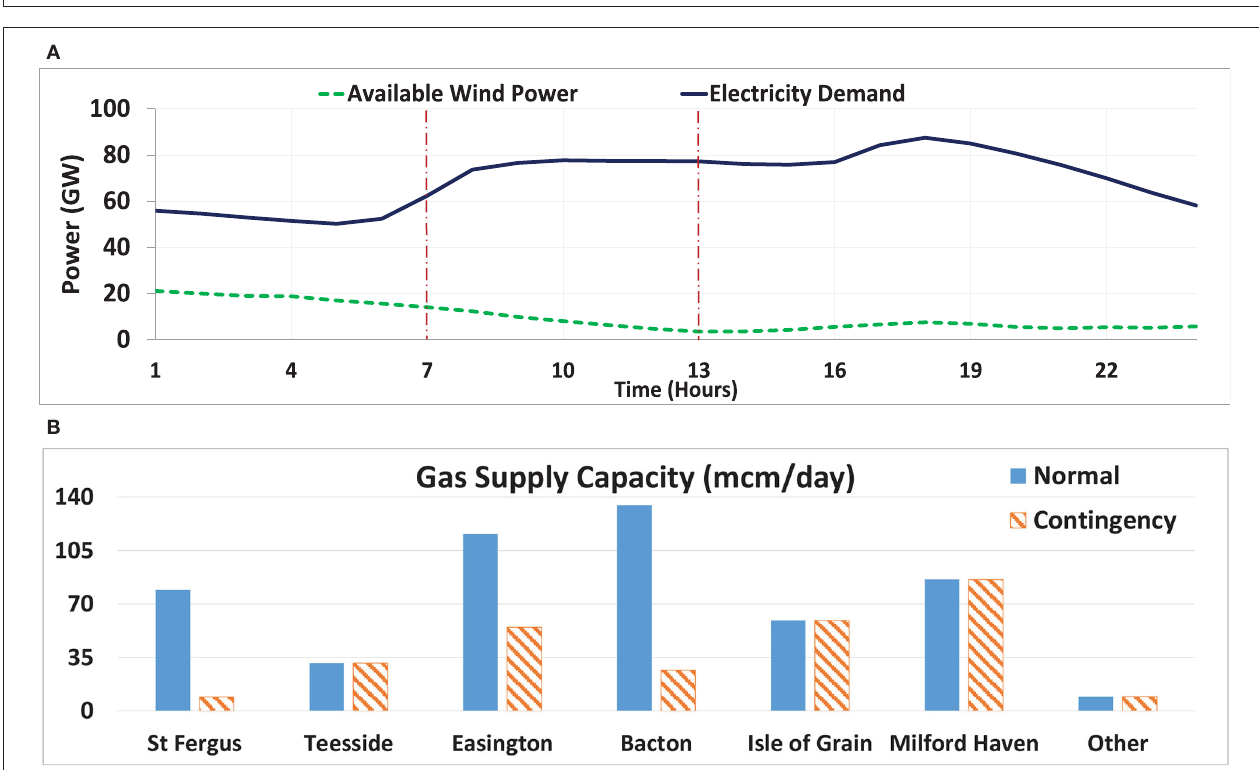
FIGURE 7 | Change in annual electricity generation in the Multi case in respect to the Ref